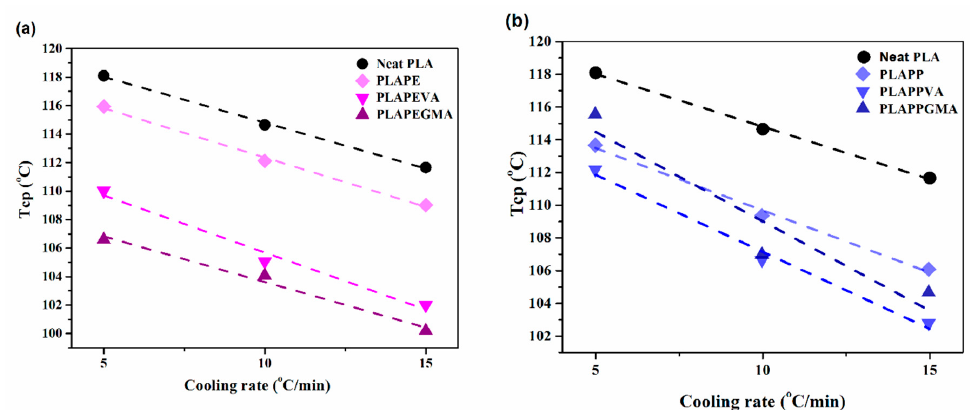
Figure 5. The effects of POEs, cooling rate, and compatibilizer on the peak crystallization temperature of the PLA matrix. ( a ) PLA blends containing PE base olefin elastomers. ( b ) PLA blends containing PP base olefin elastomers.